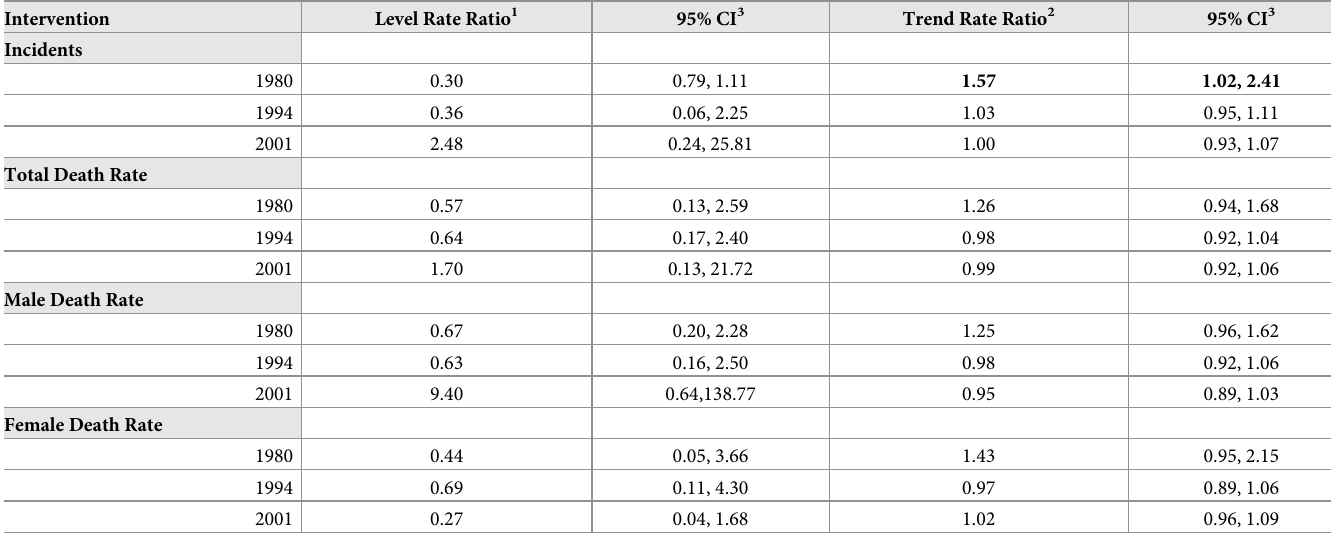
Table 2. Incidence rate ratios of firearm to non-firearm post intervention.